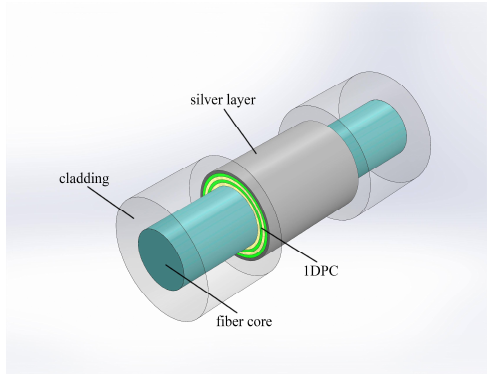
Figure 1. Structure of the solid-core fiber RI sensor based on 1 DPC/silver system.